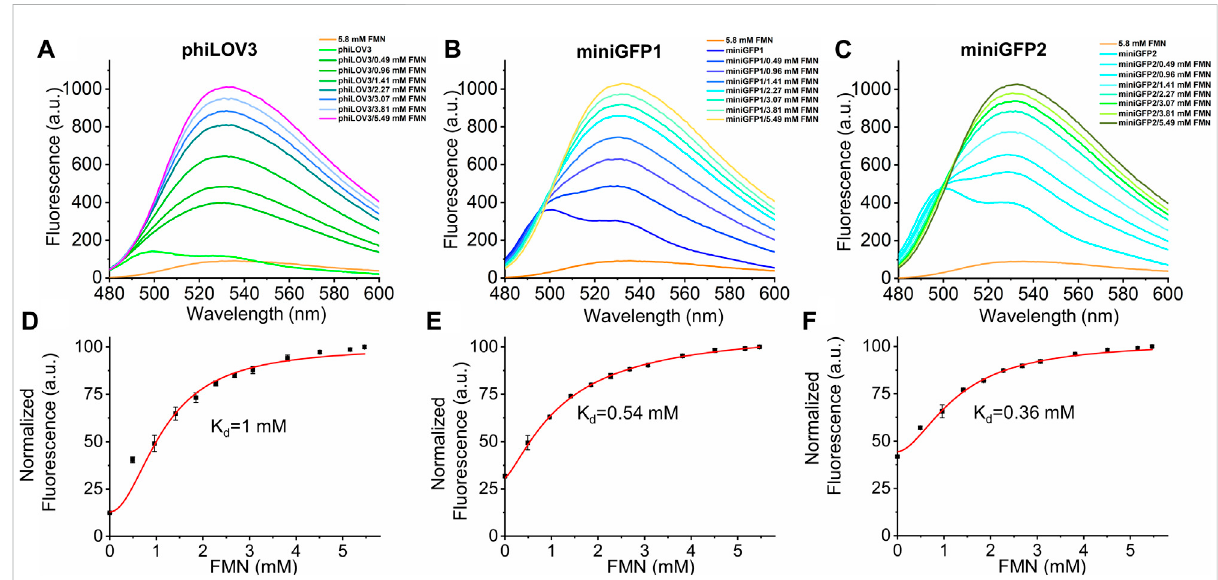
FIGURE 7 Spectral characterization of phiLOV3 and miniGFPs with an increasing concentration of exogenous FMN. (A – C) The fl uorescence emission spectra of phiLOV3 and miniGFPs with addition of FMN at the concentration ranging from 0 to 5.49 mM. Compared to pure FMN (5.8 mM, orange line),the fl uorescentspectra ofphiLOV3(greenline)miniGFP1(bule line)andminiGFP2(cyanline)allchangedafter theintroductionofFMNwiththe fl uorescence increase. (D – F) The binding af fi nity curves of phiLOV3 and miniGFPs with FMN. The corresponding of estimated K calculated by the Hill 1 equation. Dots represent mean, error bars represent standard deviation for three technical replicates